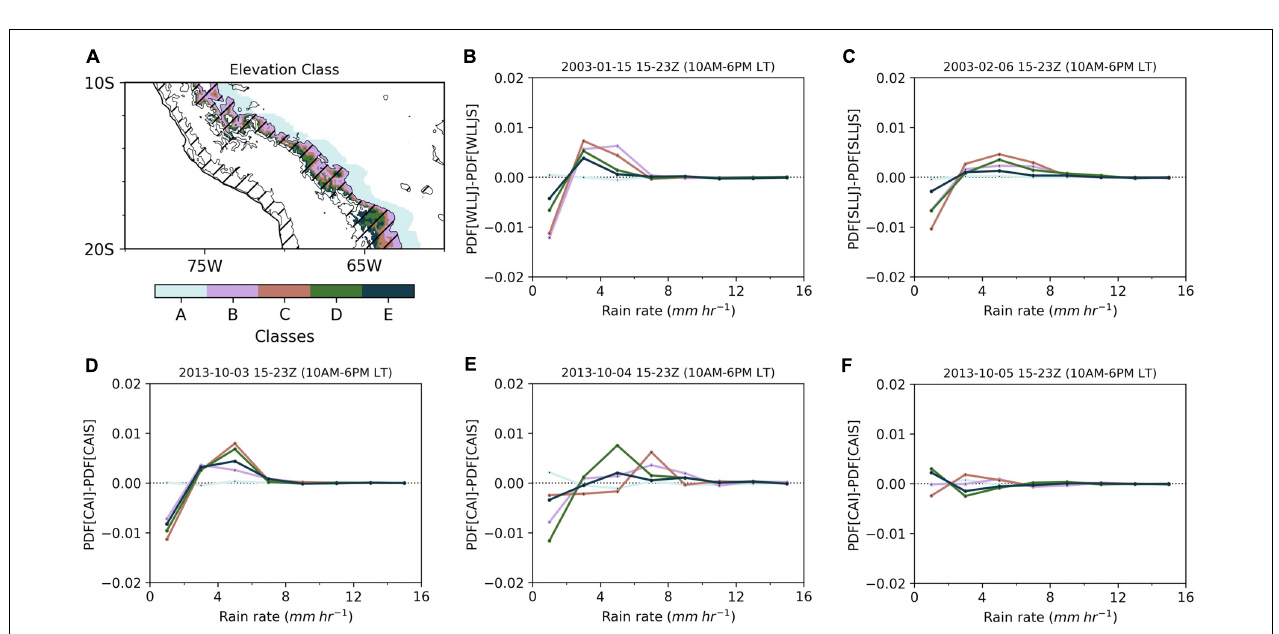
FIGURE 9 | Map of (A) elevation classes, where A corresponds to the 120 km through the east of the 500 m elevation contour, B, C, D, and D correspond to 500–1,000, 1,000–1,500, 1,500–2,000, and 2,000–2,500 m, respectively. Difference in distribution of rain rate between the control and the modified simulation from the WRF simulation (D02, 6 km) classified by elevation and 10-20S latitudes for WLLJ, SLLJ, and CAI cases are shown in (B–F) , respectively. The values for each distribution are for daytime between 15Z and 23Z corresponding to 10 a.m. to 6 p.m. local time.